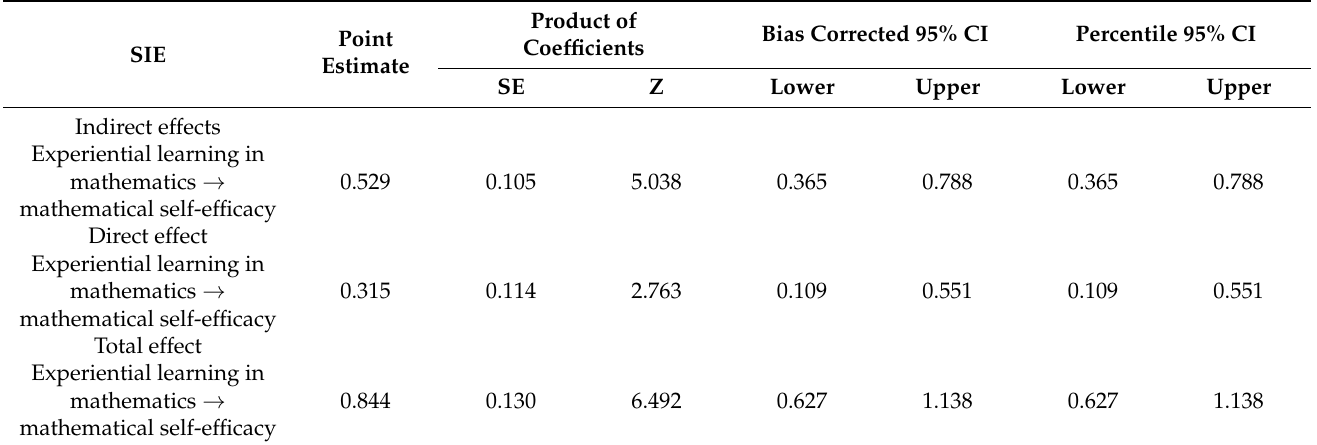
Table 4. Mediating effects of the structural